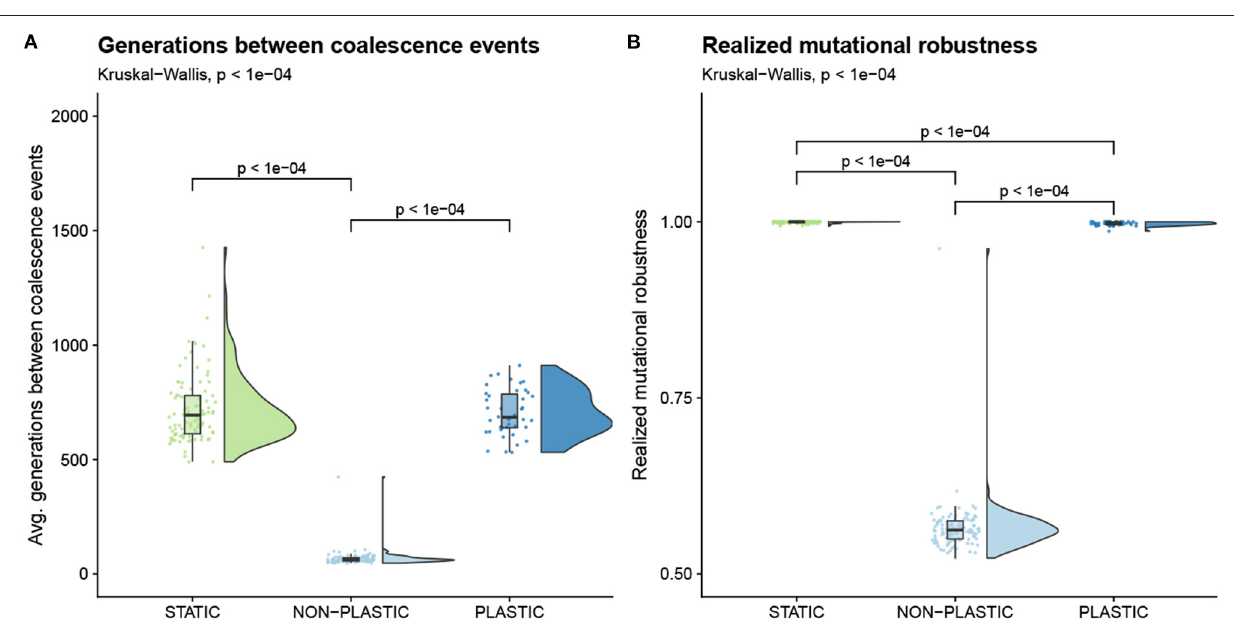
FIGURE 4 | Pace of evolutionary change. Raincloud plots of (A) average number of generations between coalescence events, and (B) realized mutational robustness ( Table 1 ). Each plot is annotated with statistically significant comparisons (Bonferroni-corrected pairwise Wilcoxon rank-sum